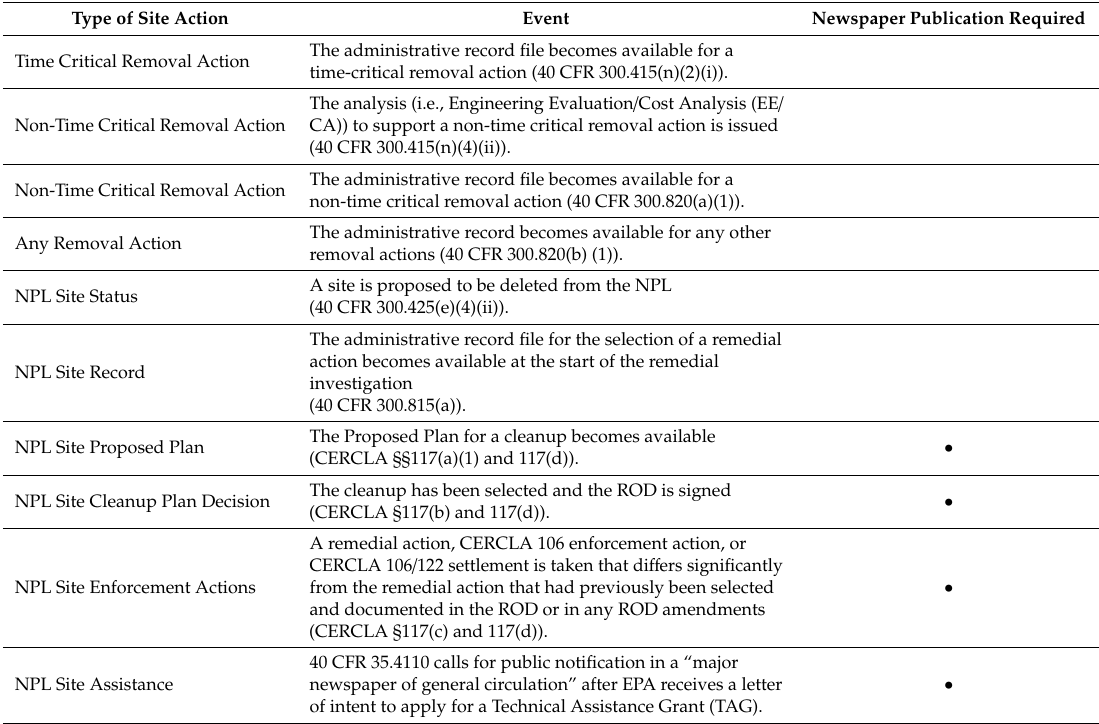
Table 2. Summary of required public notice requirements for Superfund sites